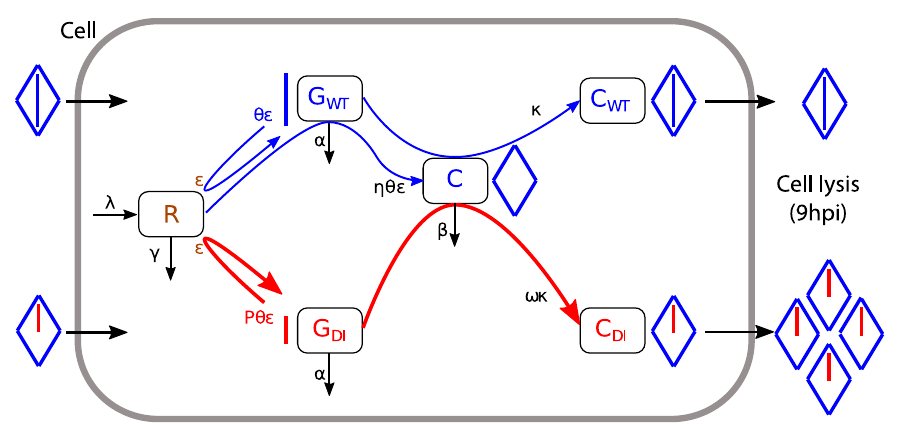
Fig 2. Flow diagram of the model (Eqs (1)–(6)). State variables: resource units number R ; wild-type (WT) poliovirus naked genome number G ; defective interfering (DI) naked genome number G ; WT-produced capsid proteins WT DI number C ; encapsidated WT genome number C WT ; encapsidated DI genome number C WT . Model parameters are defined in Table 1. Color code is blue for WT, red for DI and brown for resources. Segments represent genomes and diamonds represent capids.